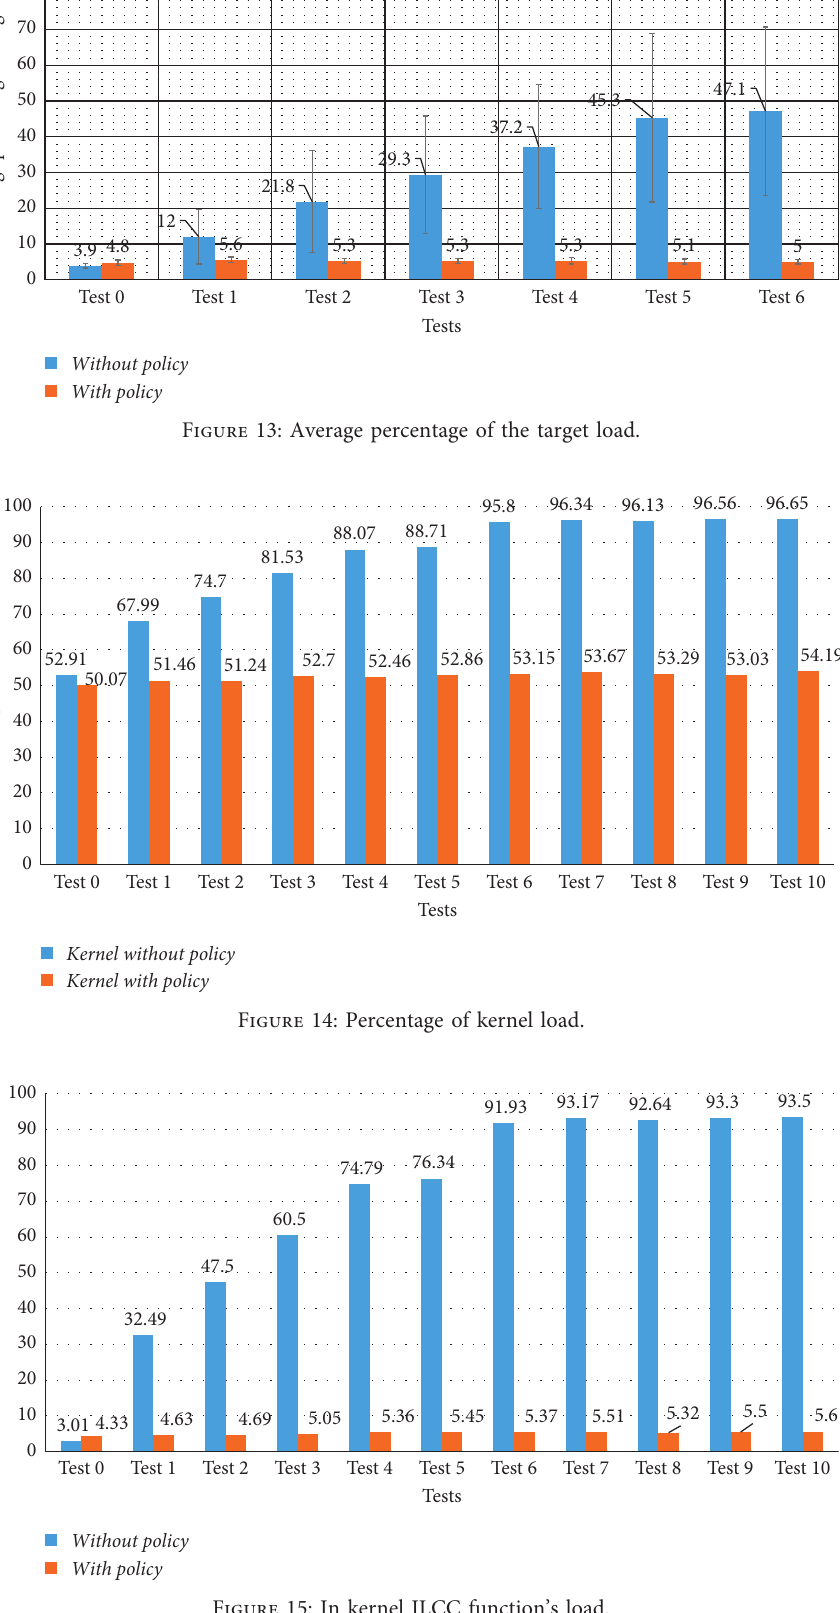
Figure 15: In kernel ILCC function’s